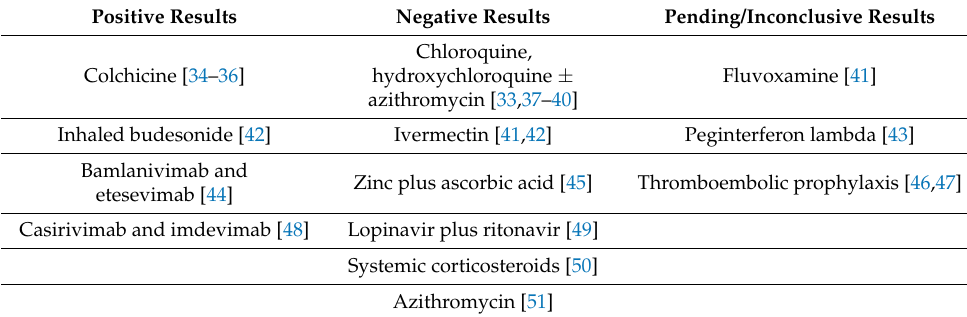
Table 3. Outpatient treatment regimen trials against